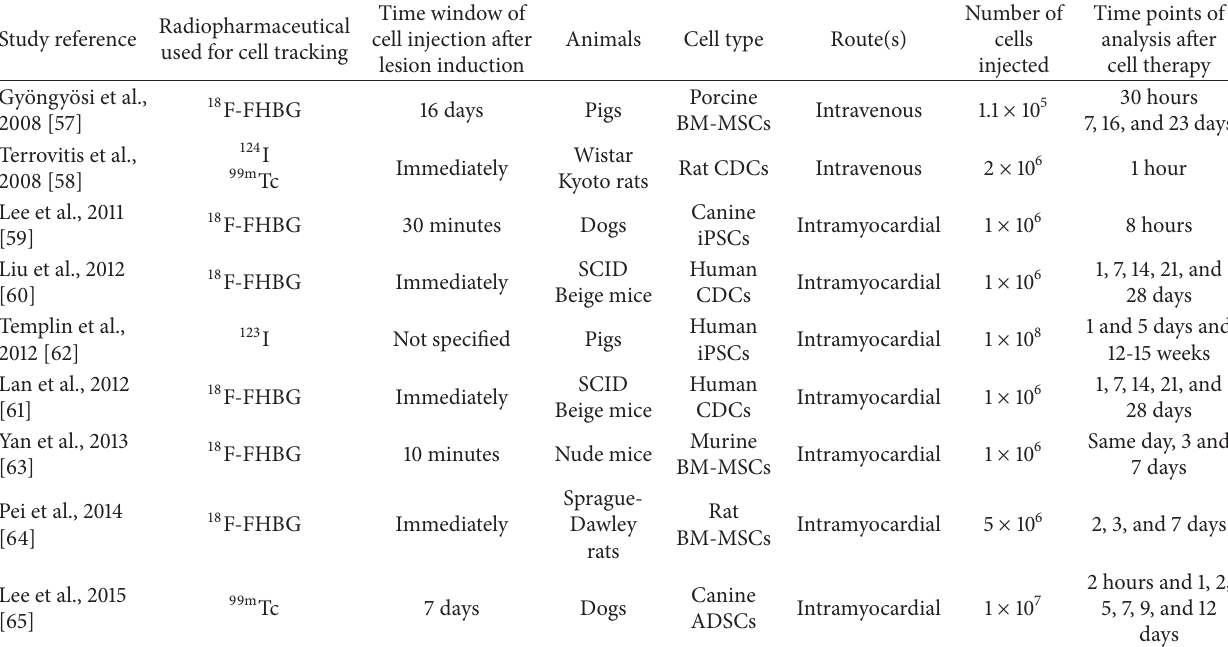
Table 2: Preclinical studies that used indirect radiopharmaceutical tracking for cell therapies in models of myocardial infarction. Radiopharmaceutical Study reference used for cell